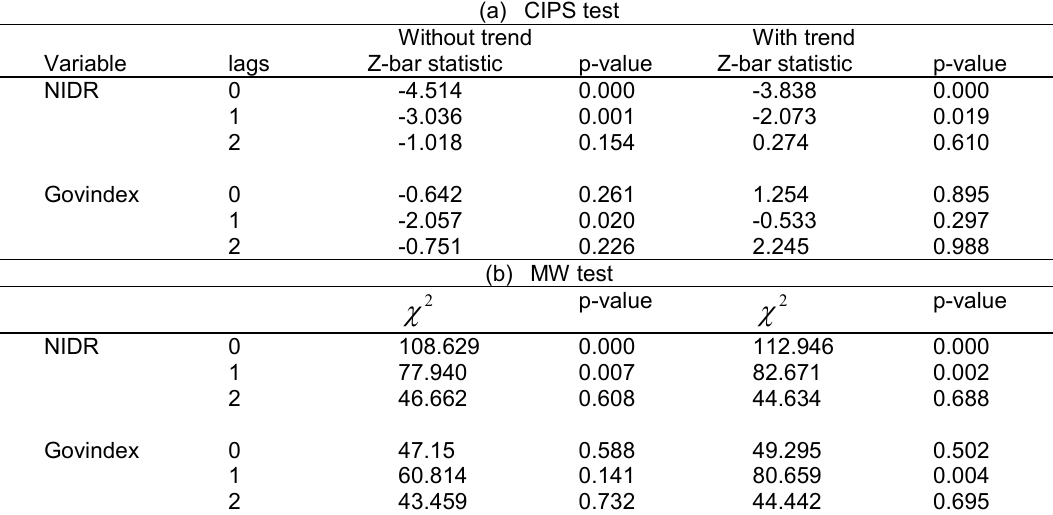
Table 7. Panel unit root tests results.